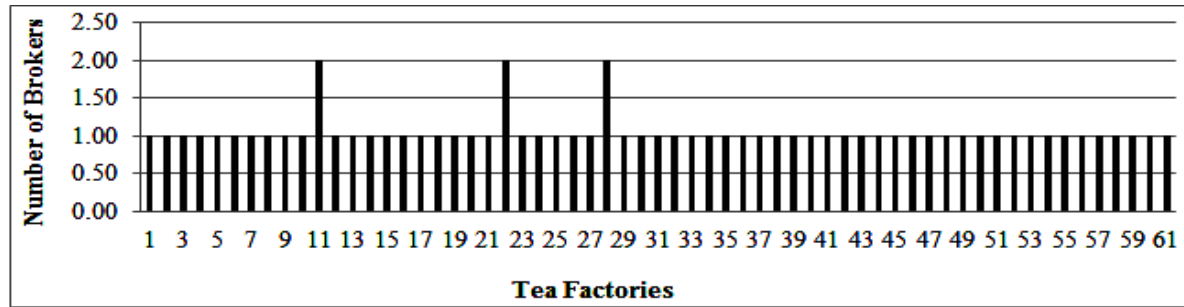
Fig 8: Number of Broker within Tea